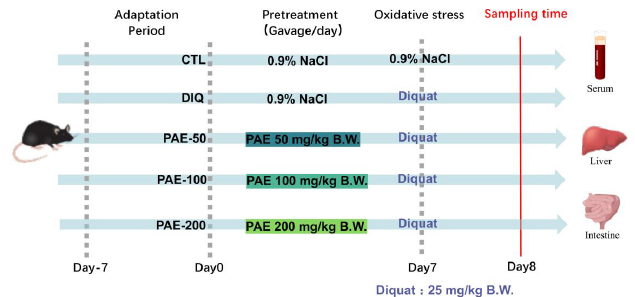
Figure 1. Experimental scheme for assigning mice into 5 groups ( n = 8).